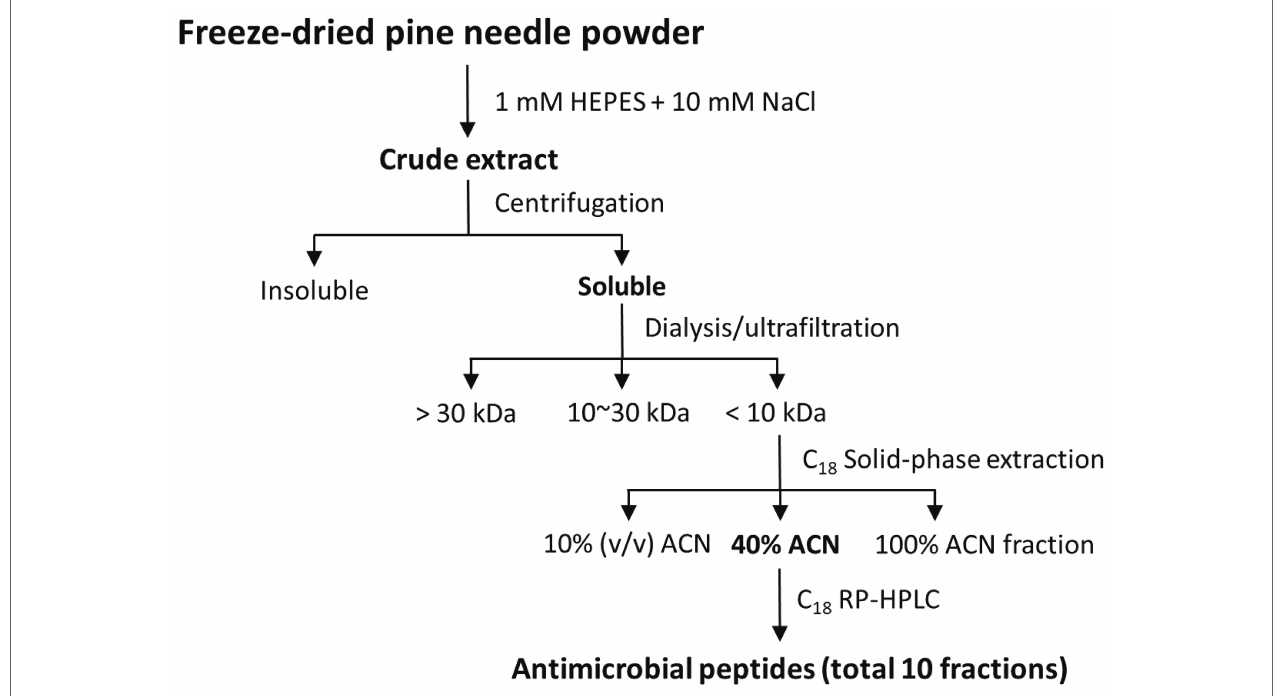
FIGURE 1 | Separation strategy of AMPs from pine